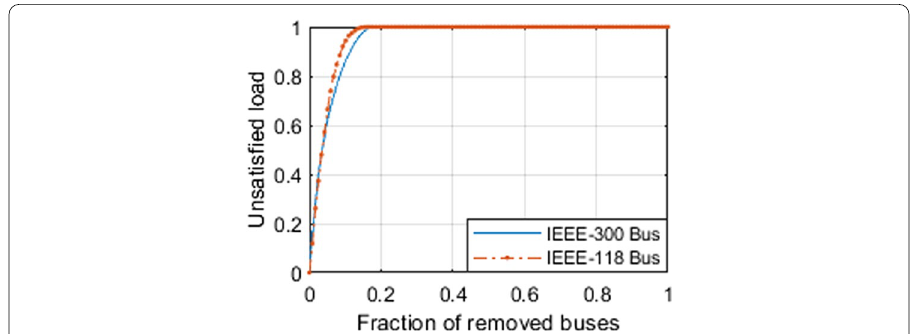
Fig. 7 Vulnerability curves produced by the IEMDE fault profile for IEEE 118-bus and IEEE 300-bus systems